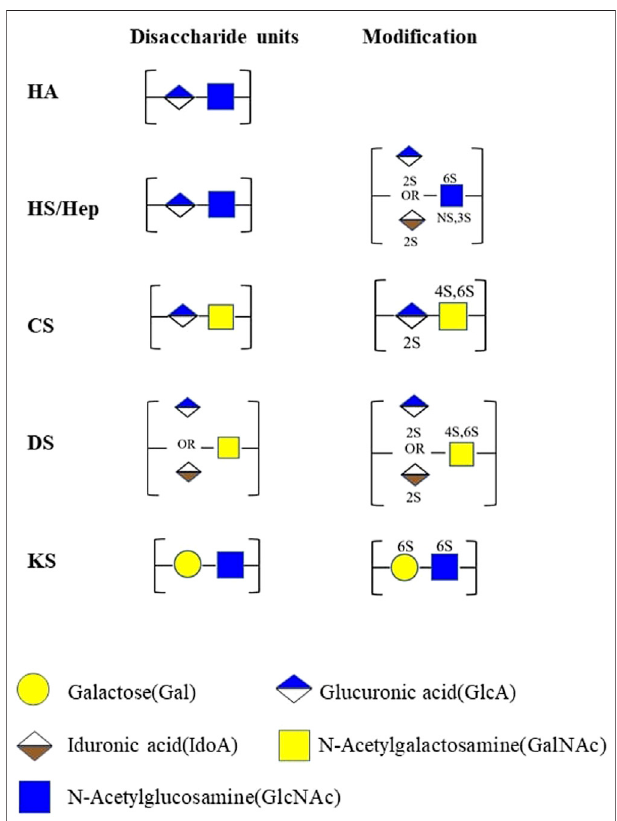
FIGURE 1 | Structures of GAGs and their modi fi cation. HA, hyaluronan; HS, heparan sulfate; Hep, heparin; CS, chondroitin sulfate; DS, dermatan sulfate; KS, keratan sulfate; 2S, 2-O-sulfation; 6S, 6-O-sulfation; 3S, 3-O- sulfation; 4S, 4-O-sulfation; NS, N-sulfated